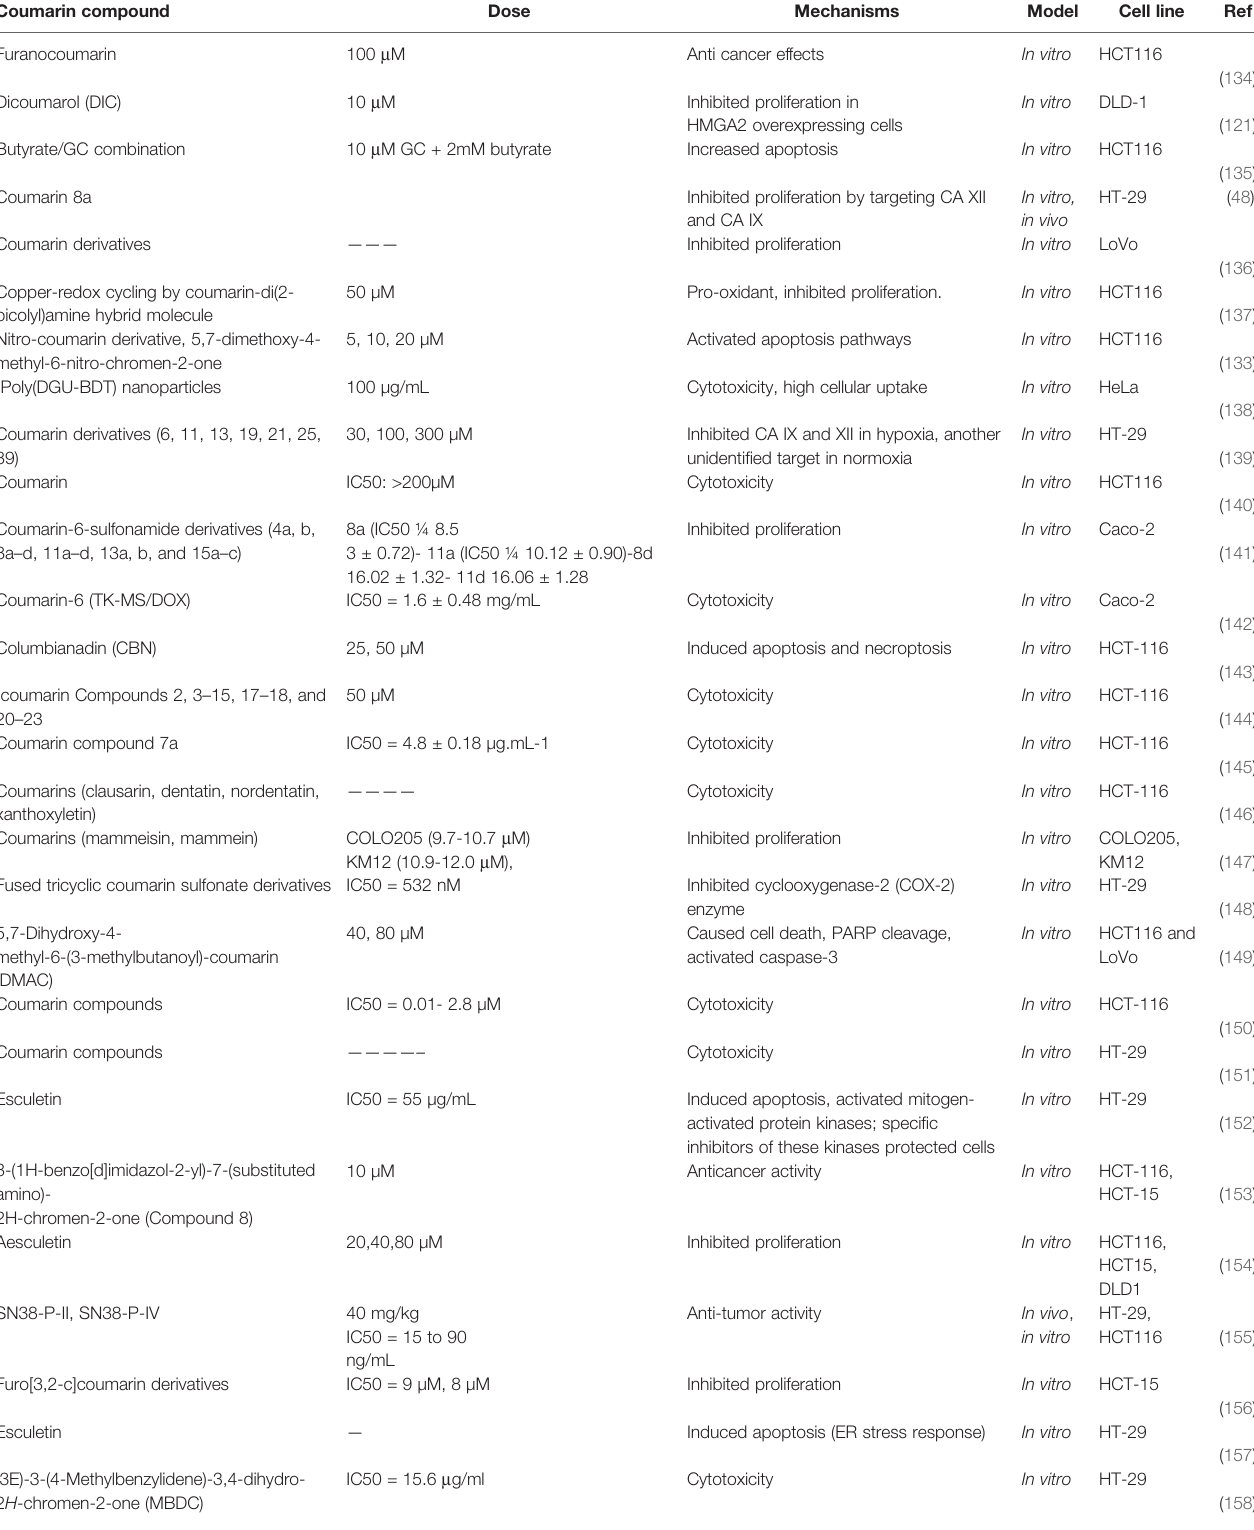
TABLE 2 | Anti-colon cancer effects of